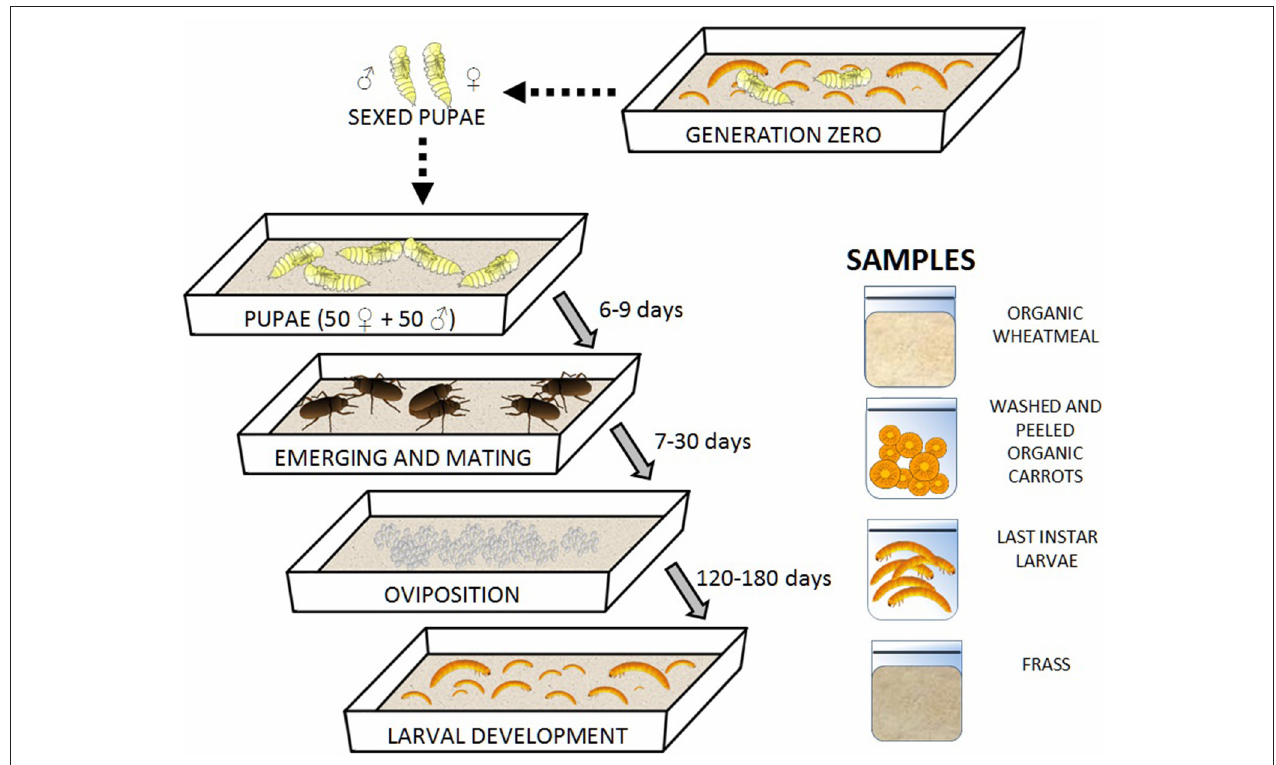
FIGURE 1 | Rearing steps of mealworms and collected